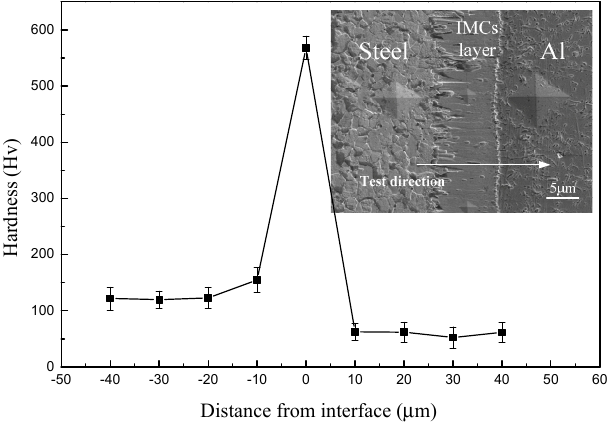
Figure 11. Distribution of Vickers hardness across the interface.